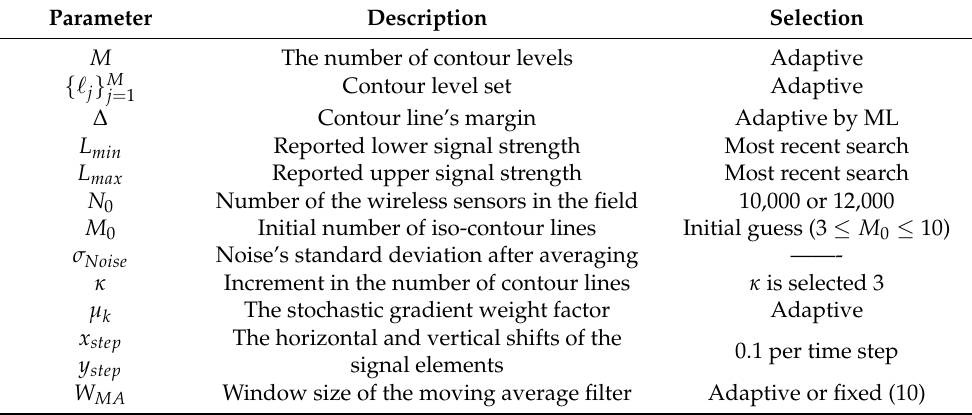
Figure 2. A subset of the sensors that are modeled as neurons report to the FC for feature extrac- tion purpose. Table 1. Parameters of the proposed